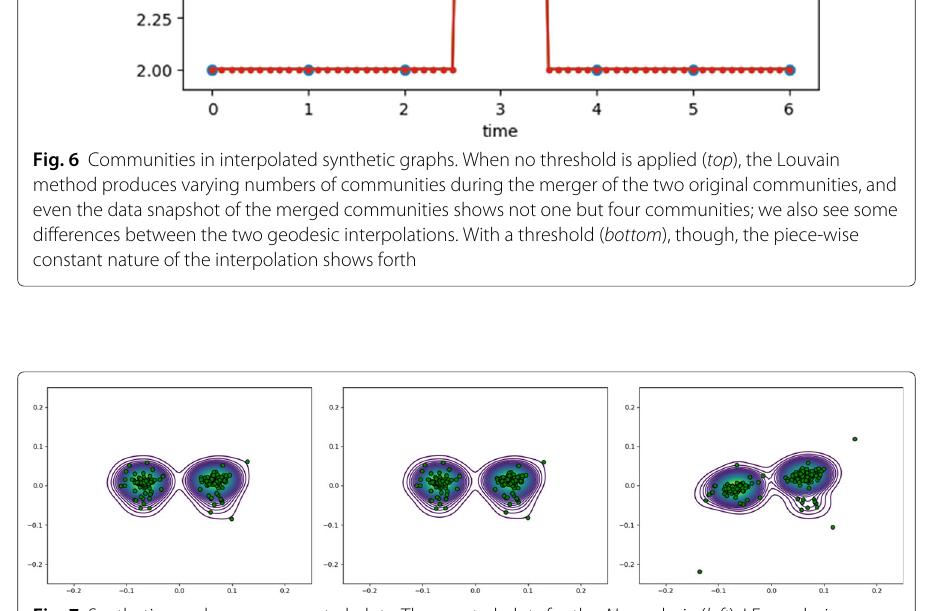
Fig. 7 Synthetic graph average spectral plots. The spectral plots for the AI geodesic ( left ), LE geodesic ( center ), and linear ( right ) means are all very similar: the geodesic interpolations produce indistinguishable means, and the linear interpolation’s mean is only slightly different from the